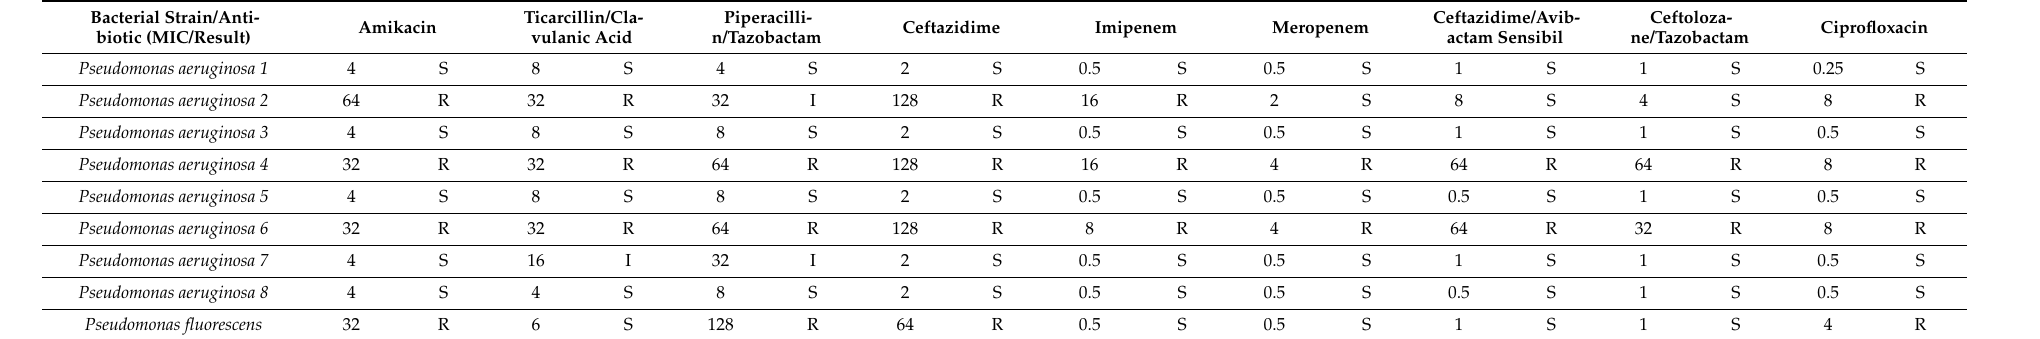
Table 9. MICs (mg/L) of antimicrobials for Pseudomonas spp. isolates.